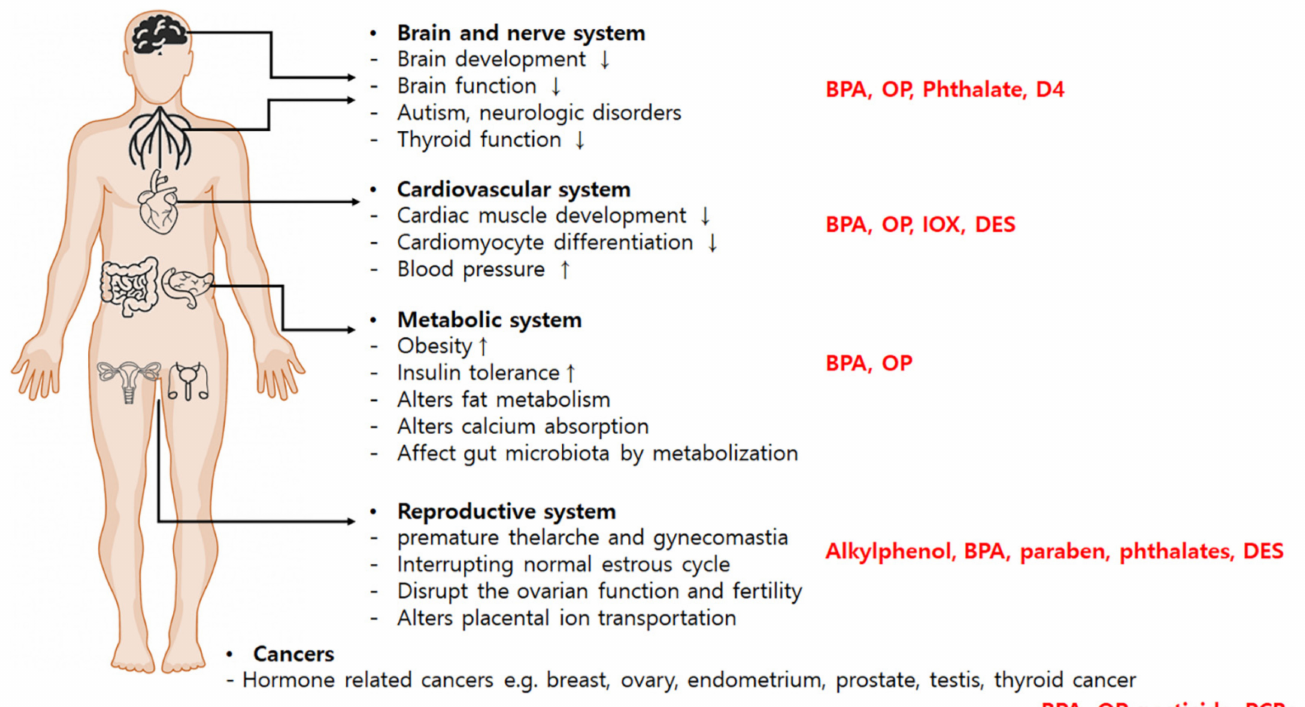
Figure 1. Schematic overview of endpoints of diseases affected by Endocrine Disrupting Chemicals (EDCs). Exposure to EDCs contributes significantly to the onset and progression of organ develop- ment and disorders such as reproductive, metabolic, neurologic, cardiovascular disease, and cancers; these EDCs include Bisphenol A (BPA), octylphenol (OP), octamethylcyclotetrasiloxane (D4), ioxynil (IOX), diethylstilbestrol (DES), polychlorinated biphenyls